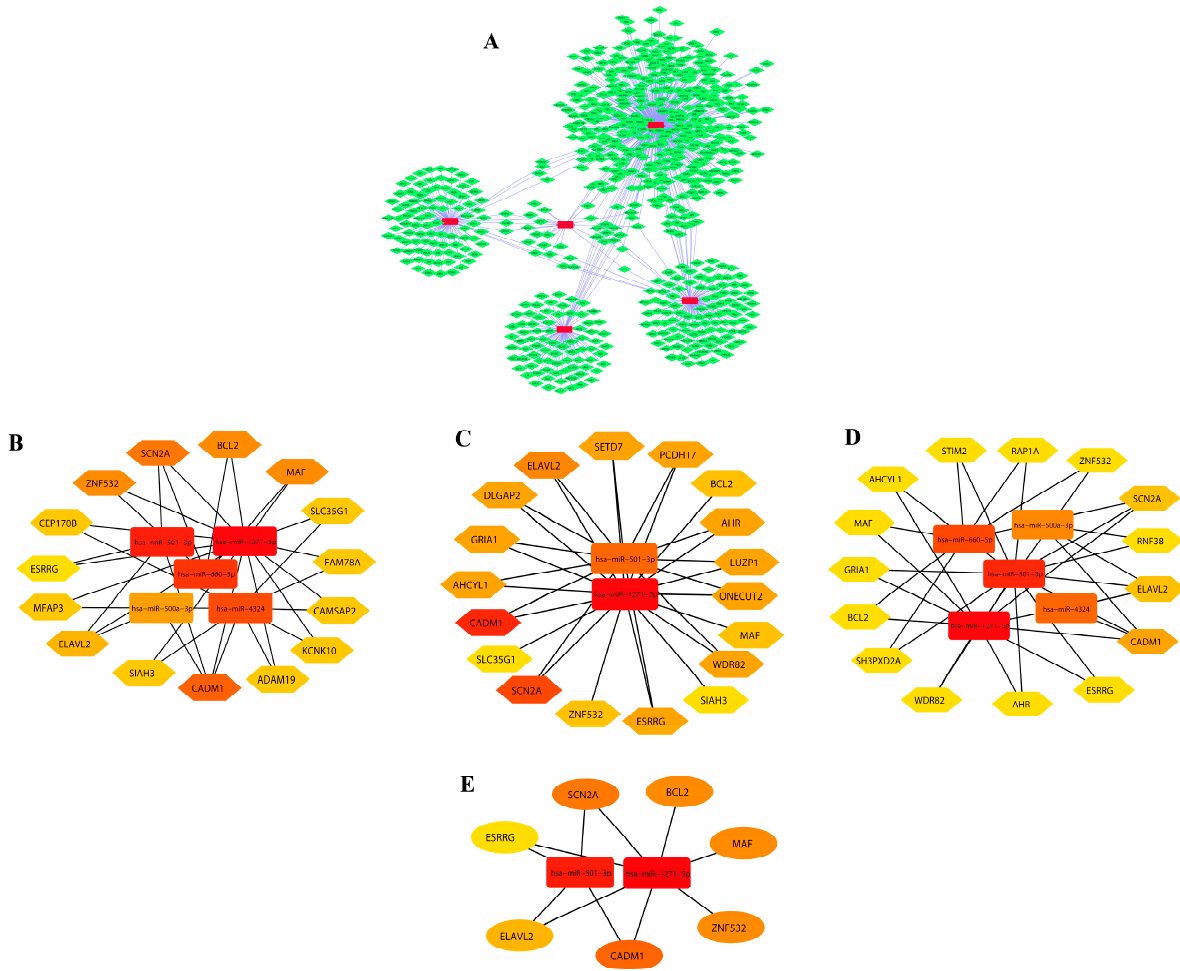
Figure 2. (A) Downregulated network of miRNAs and their associated target genes . The associated Figure 2. ( A ) Downregulated network of miRNAs and their associated target genes. The associated genes genes were further identified on the basis of centrality measures. ( B) On the basis of betweenness. were further identified on the basis of centrality measures. ( B ) On the basis of betweenness. ( C ) On the ( C) On the basis of closeness. (D) On the basis of degree. (E) Common genes obtained from signifi- cant modules. basis of closeness. ( D ) On the basis of degree. ( E ) Common genes obtained from significant